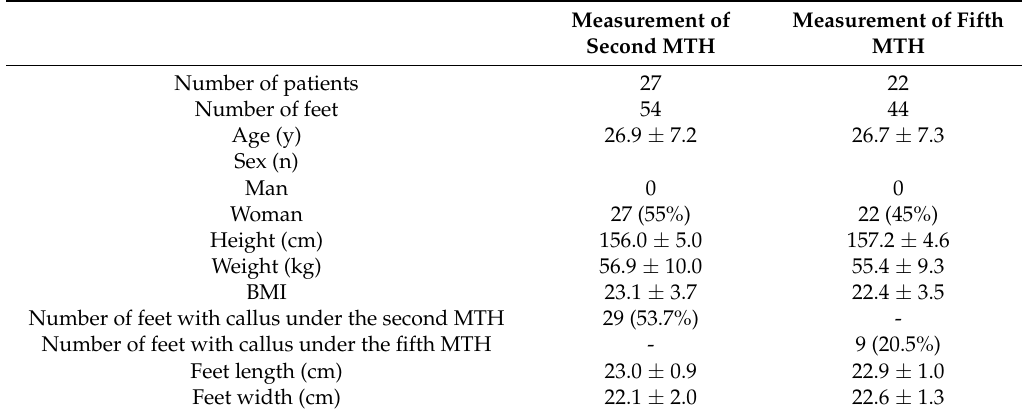
Table 1. Patient characteristics.